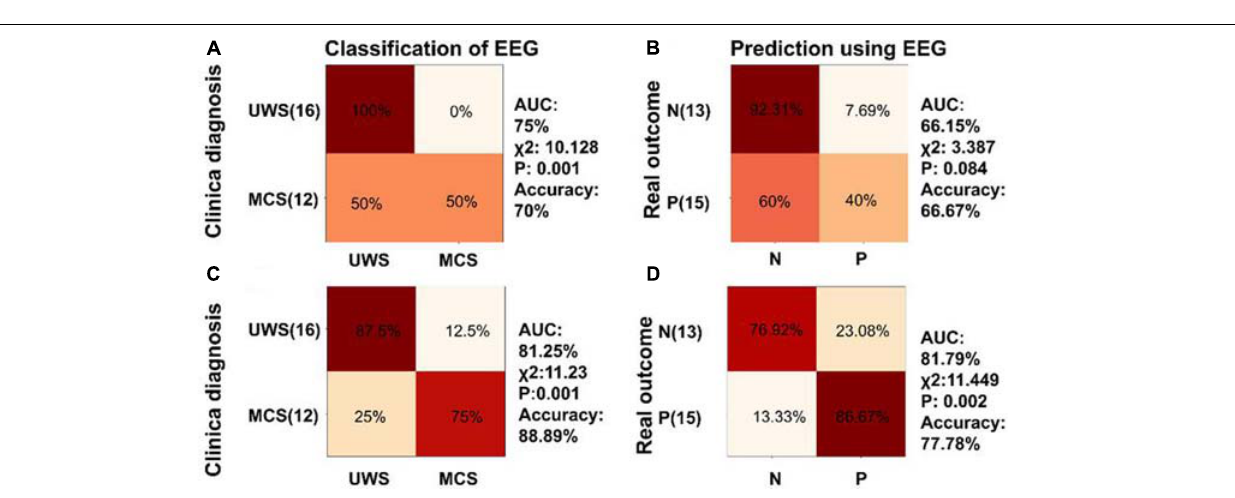
FIGURE 7 | Classification and prognosis prediction in DOC using neural synchronization to temporal modulations at low and high frequencies. (A) Diagnosis classification using phase coherence at 41 and 41 ± 2 Hz performed well (AUC = 87.08%, accuracy = 70%, χ 2 = 17.052, P = 0.001). Confusion matrix generated by SVM showed 86.67% sensitivity and 87.5% specificity for MCS diagnosis. (B) The SVM classifier trained using phase coherence at 41 and 41 ± 2 Hz showed good performance in prognosis prediction of DOC (AUC = 83.4%, accuracy = 90%, χ 2 = 14.072, P = 0.001) and was able to predict positive prognosis of individual patients with high sensitivity (88.24%) and specificity (78.57%). (C,D) The SVM classifier showed poor performance in classification and prognosis prediction of DOC trained using phase coherence at 2 and 4 Hz.